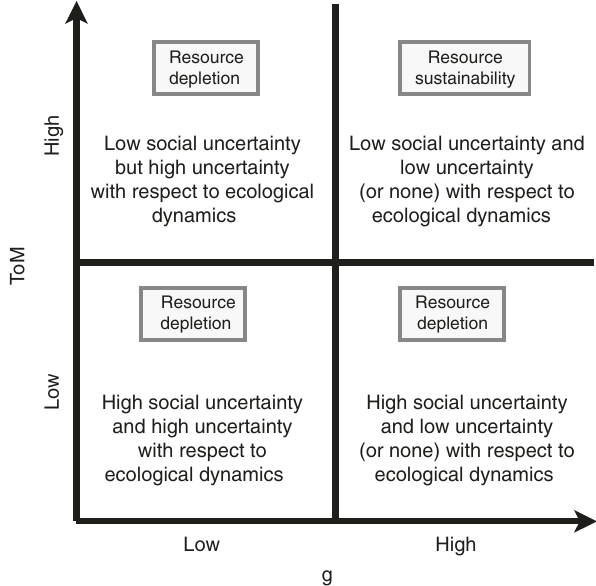
Fig. 1 Predicted interaction effects of g and ToM on the ability of groups to harvest resources and adapt to changes in resource